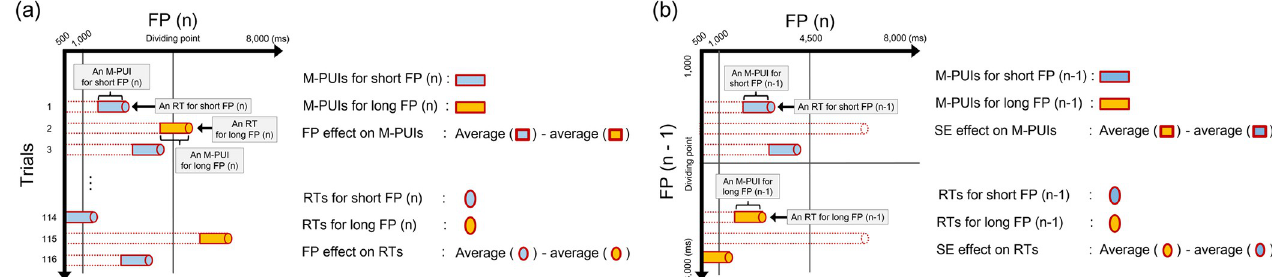
Fig 4. (a) Calculating FP effect on RT and M-PUI, and (b) calculating SE effect on RT and